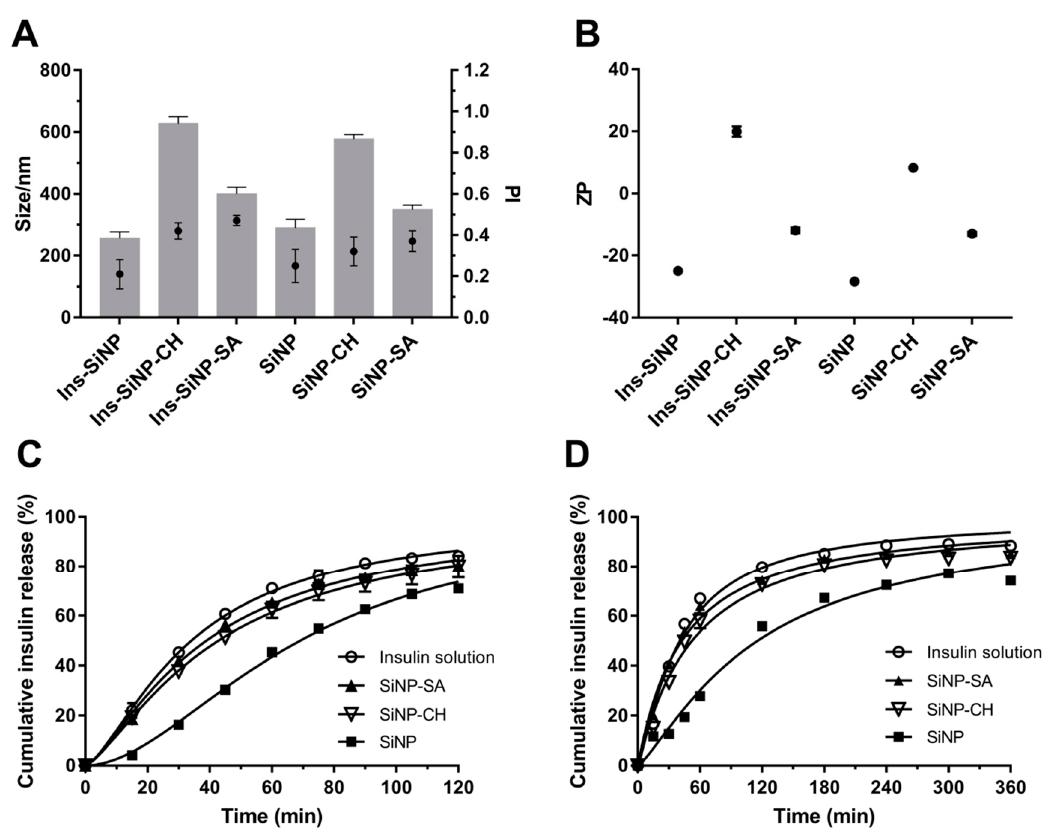
Figure 3. Influence of polysaccharides on nanoparticles properties. Effect of chitosan (CH) and sodium alginate (SA) on Z-Ave (size, nm, denoted as bars) and PI (denoted as full circle) ( A ) and ZP ( B ) of the uncoated and coated formulations. Release profile of free insulin and insulin from nanoparticles in KCl/HCl buffer pH 2.0 ( C ) and PBS pH 6.8 ( D ) at 37 °C. Each point on the curve is the mean of at least three experiments ± SD. Statistical difference between free insulin and insulin loaded nanoparticles is considered with p ˂ 0.05. The statistically different formulations at pH 2.0 are: free insulin vs. SiNP in all time points; free insulin vs. SiNP-CH from 15 to 105 min; free insulin vs. SiNP-SA at 60 and 90 min. At pH 6.8, the statistically different formulations are: free insulin vs. SiNP in all time points; free insulin vs. SiNP-CH from 30 to 360 min; free insulin vs. SiNP-SA at 15, 120 and 360 min.